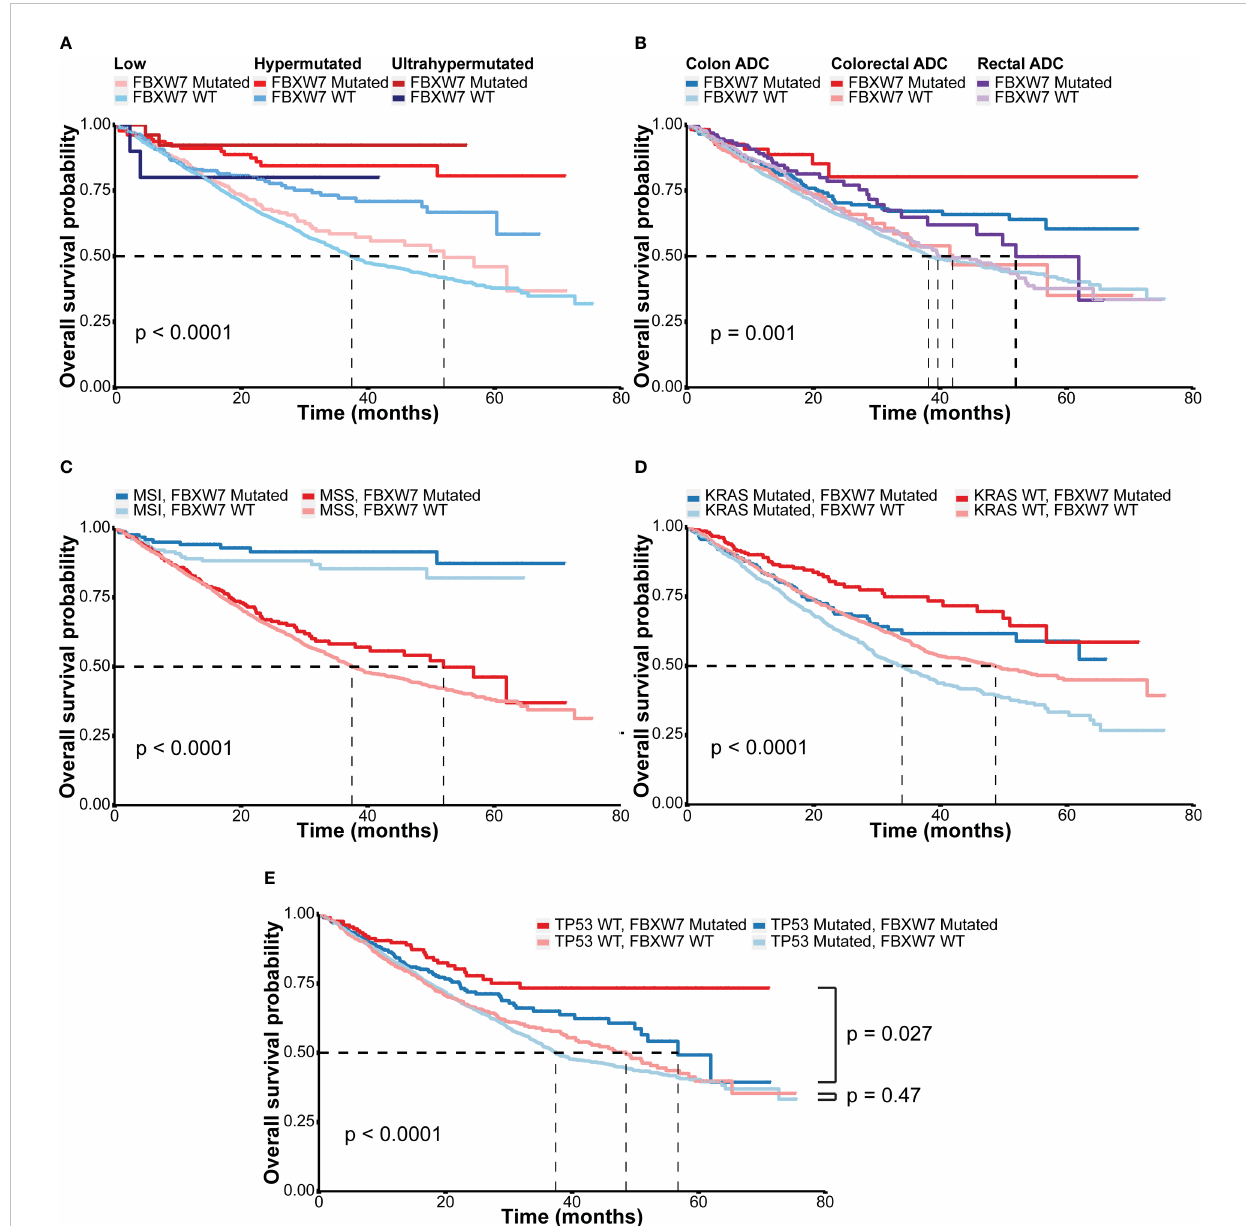
FIGURE 3 Overall survival outcomes of different subgroups in the MSK cohort. (A) Kaplan-Meier overall survival curves of colorectal cancer patients according to hypermutation status and FBXW7 mutation status; (B) Kaplan-Meier overall survival curves of colorectal cancer patients according to tumor sites and FBXW7 mutation status; (C) Kaplan-Meier overall survival curves of colorectal cancer patients according to microsatellite status and FBXW7 mutation status; (D) Kaplan-Meier overall survival curves of colorectal cancer patients according to KRAS mutation status and FBXW7 mutation status; (E) Kaplan-Meier overall survival curves of colorectal cancer patients according to TP53 mutation status and FBXW7 mutation